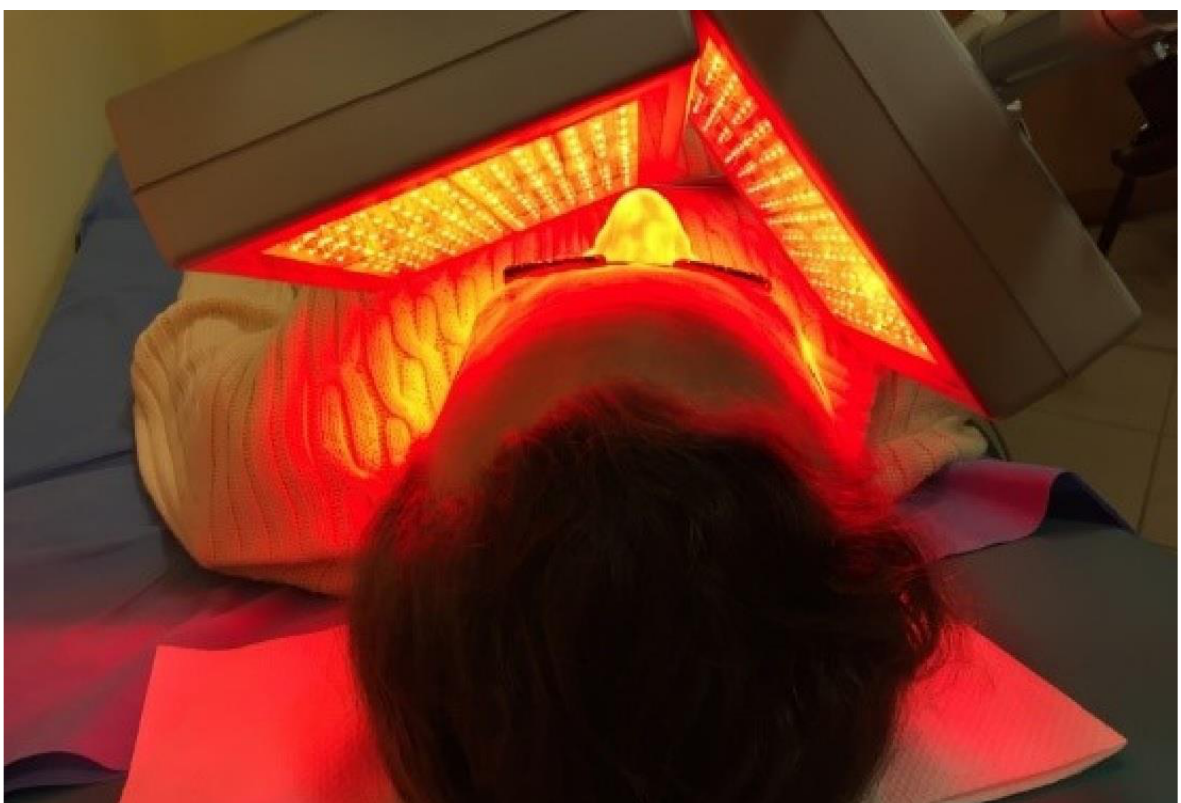
Figure 4. Therapeutic treatment with the simultaneous use of electromagnetic field and high-power light emitted by LEDs, applied by means of two panel applicators of the Viofor JPS Magnetic Light device.